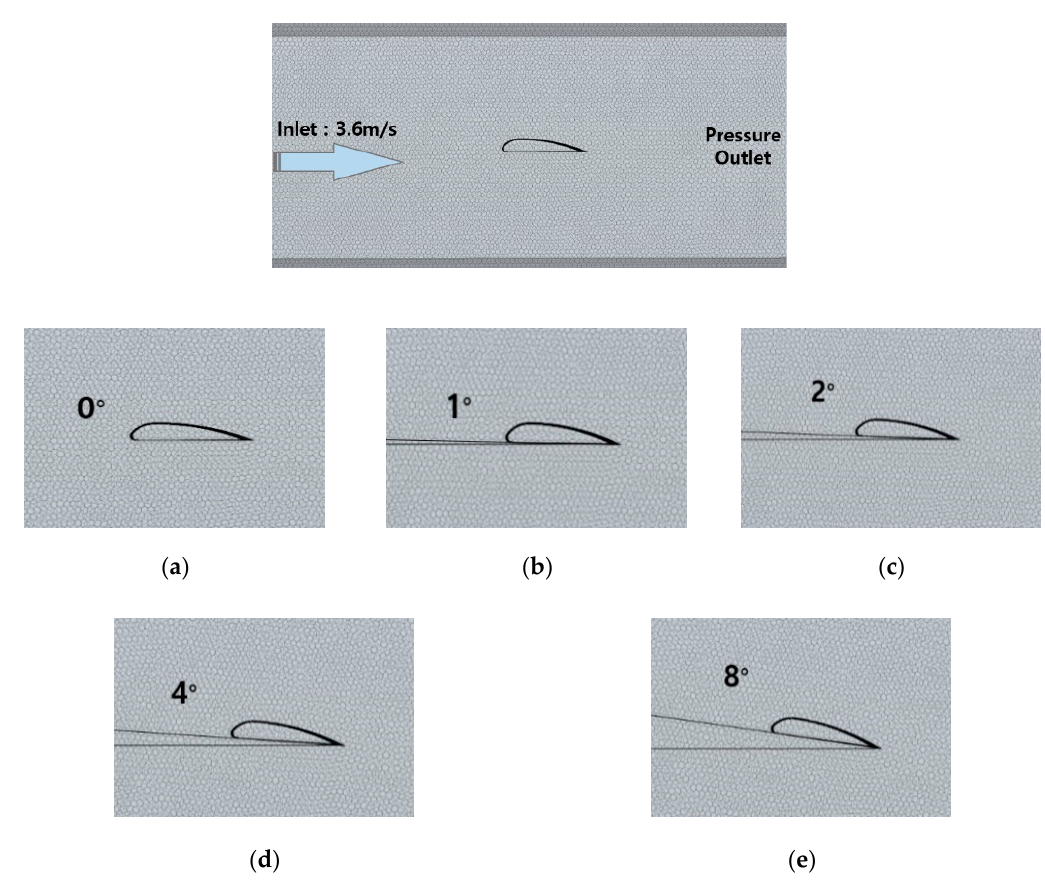
Figure 8. Diagrams showing the angles used in the simulation. ( a ) 0°, ( b ) 1°, ( c ) 2°, ( d ) 4°, ( e ) 8°. Table 3. Mesh validation diagnostic result.